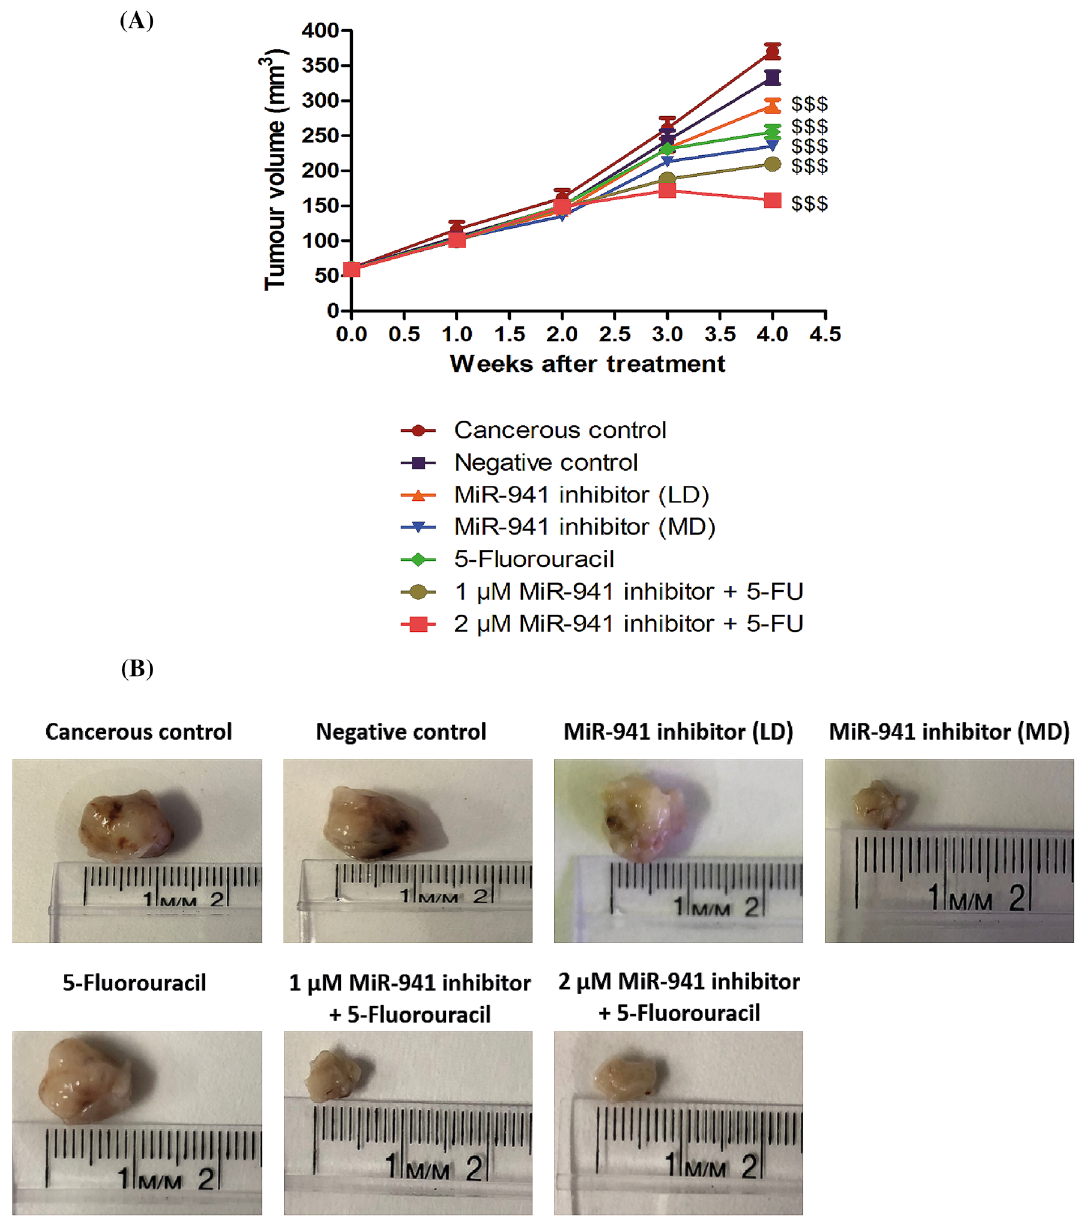
Figure 6. MicroRNA-941 inhibitor showed anti-cancer effect in MDA-MB-231 xenograft model of nude mice. ( A ) Comparative anti-cancer activity in MDA-MB-231 subcutaneous xenograft nude mice model of triple negative breast cancer. Triple negative breast cancer was induced in nude mice by implanting MDA-MB-231 triple negative breast cancer cells into the mammary fat pad of the mice. The tumour was allowed to grow till 60 mm 3 . Thereafter, treatments were evaluated over a period of 4 weeks. Data represents mean ± S.E.M. of 5 mice per group. $$$ p < 0.001 significant vs negative control. ( B ) Representative tumours excised out of mice at end point for untreated (Cancerous control group), negative control (scrambled miRNA sequence), Low dose MiR-941 inhibitor (LD = 1 µM), Medium dose MiR-941 inhibitor (MD = 2 µM), Positive control